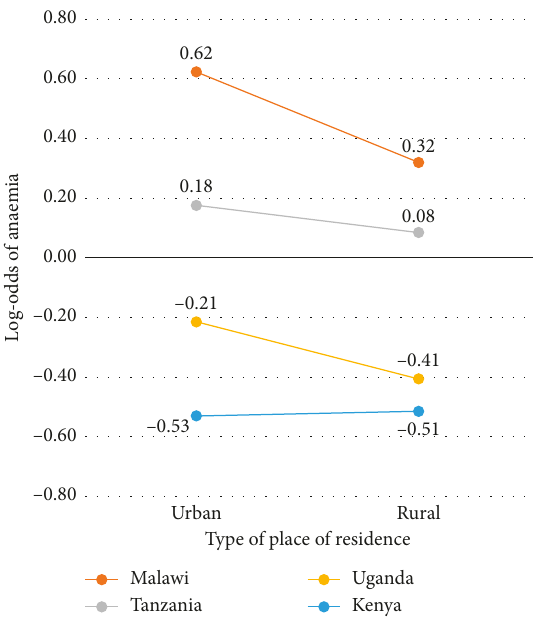
Figure 2: Log-odds of anaemia associated with the type of place of residence and Table 2: Variance estimates of nonlinear terms.